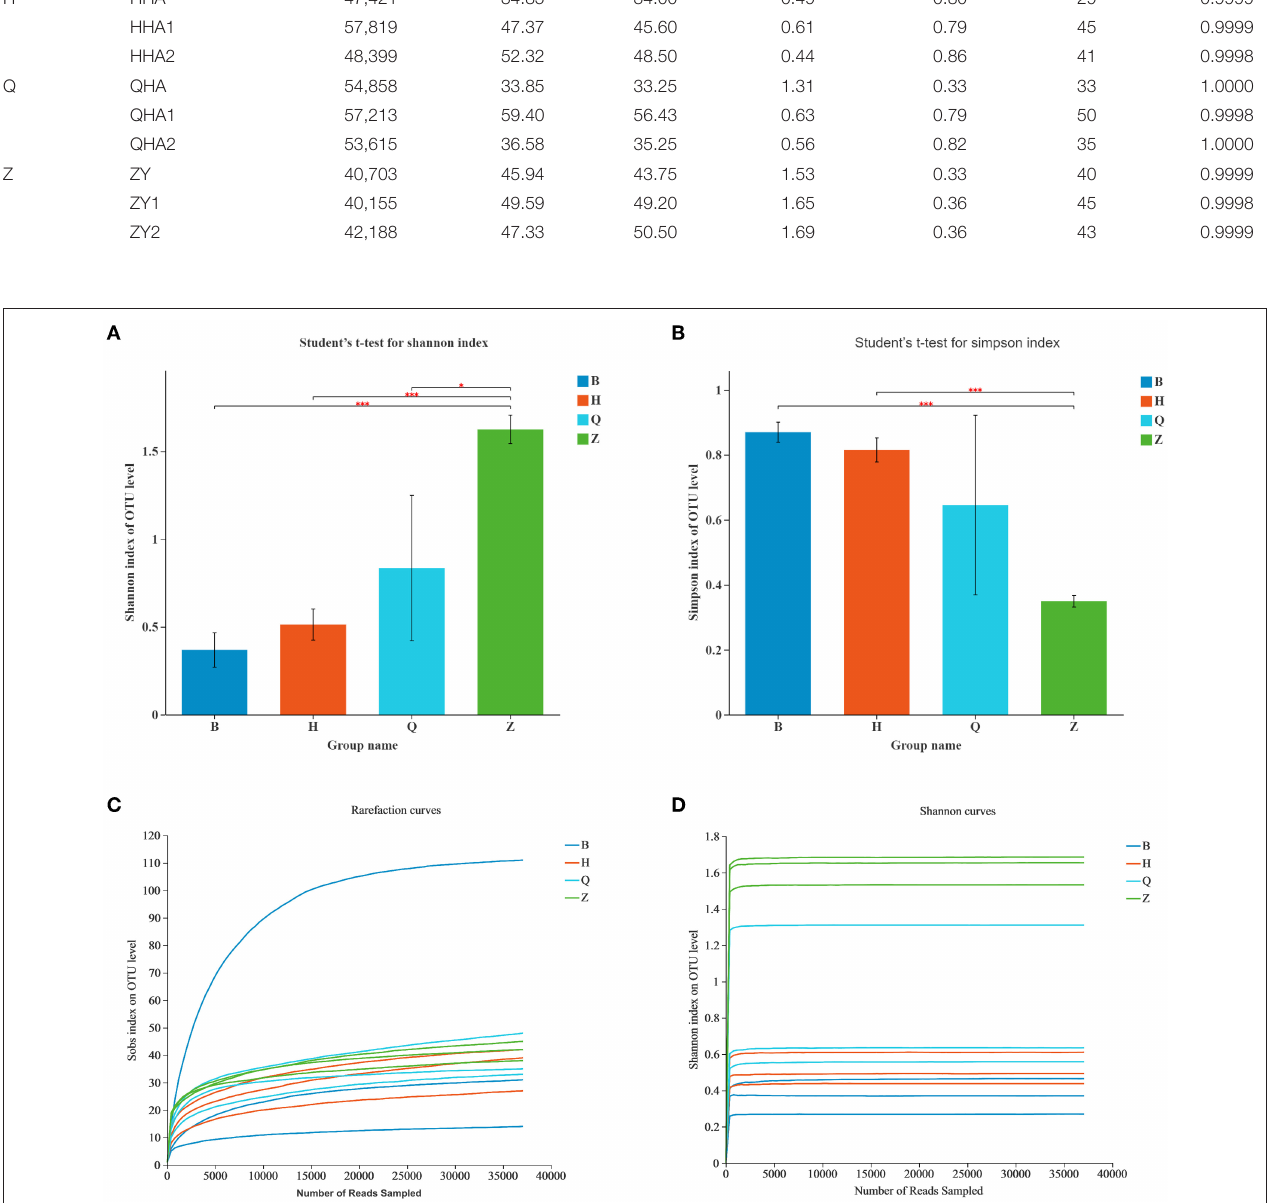
FIGURE 2 | Alpha-diversity of the bacterial community in Hurunge samples. (A) The bacterial diversity is estimated by the Shannon index. (B) The bacterial diversity is estimated by the Simpson index. (C) Sob index curve of each sample and (D) Shannon index curve.